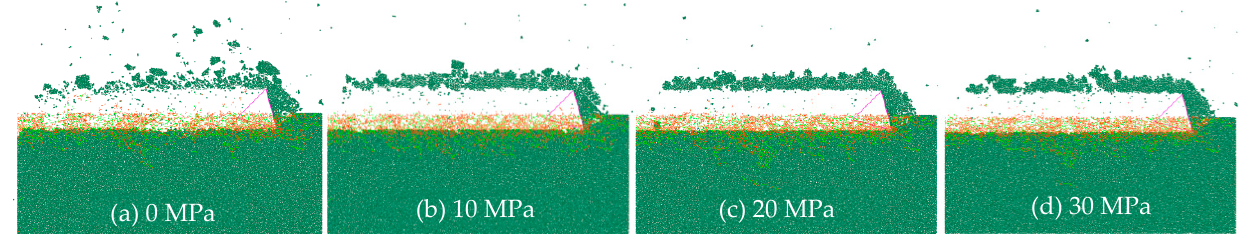
Figure 12. Crack distribution diagram.